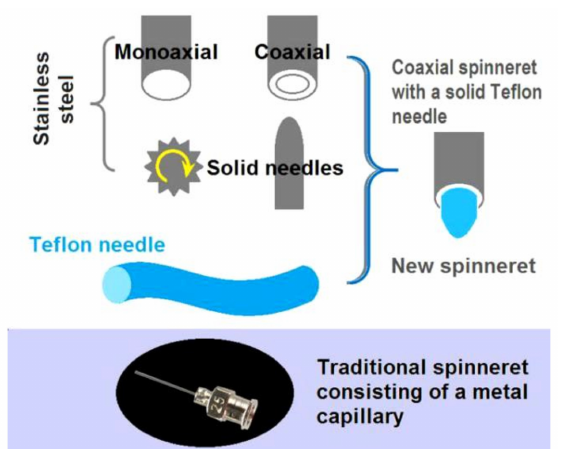
Figure 2. Conceptualization of the concentric spinneret with a solid Teflon-core rod and a traditional stainless steel needle utilized as the